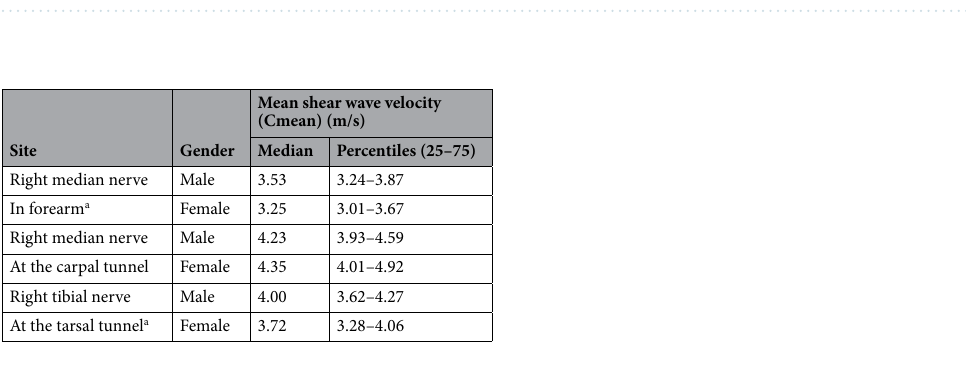
Table 7. Comparison of shear wave velocities of right median nerve at forearm in different age and BMI groups.